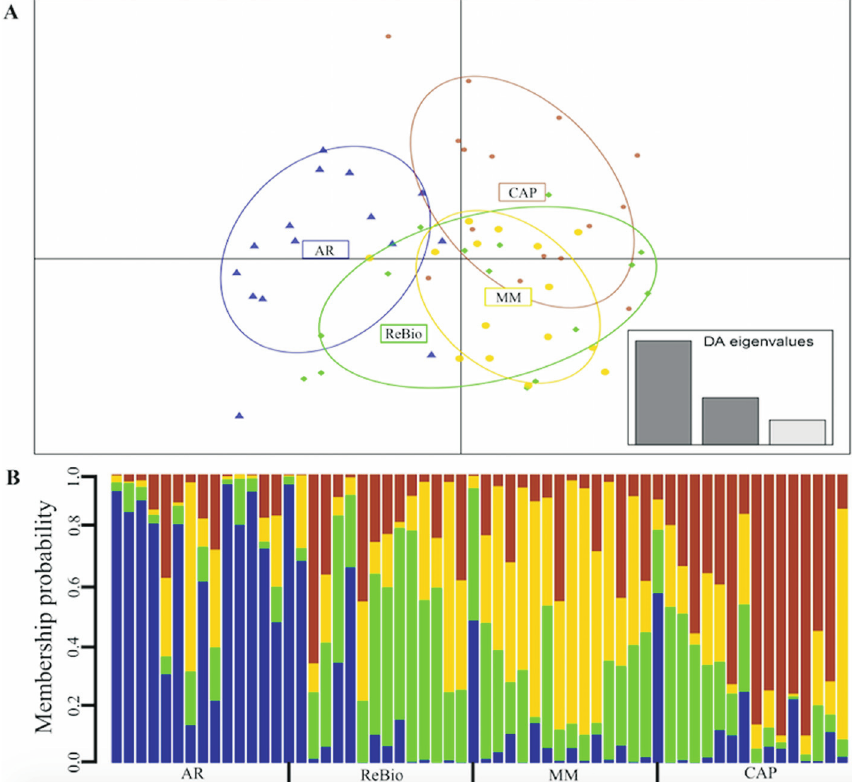
Figure 6 - Genetic differentiation among the four E. ovata subpopulations based on nSSR markers. A) The graph represents the individuals as dots and thesubpopulationsasellipsesaccordingtotheiroriginalgroups,whichmodel95%ofthecorrespondingvariabilityplotted.Thesubpopulations(ellipses) areplottedwithintheorthogonalspacedefinedbythefirsttwoeigenvaluesofthePCA(inserts).B)Diagramrepresentingthegenepooloftheindividuals associated with each of the subpopulations. Each vertical bar represents an individual with the height of the column segments showing the probability of being assigned to one of the four subpopulations. Dark lines correspond to the collection